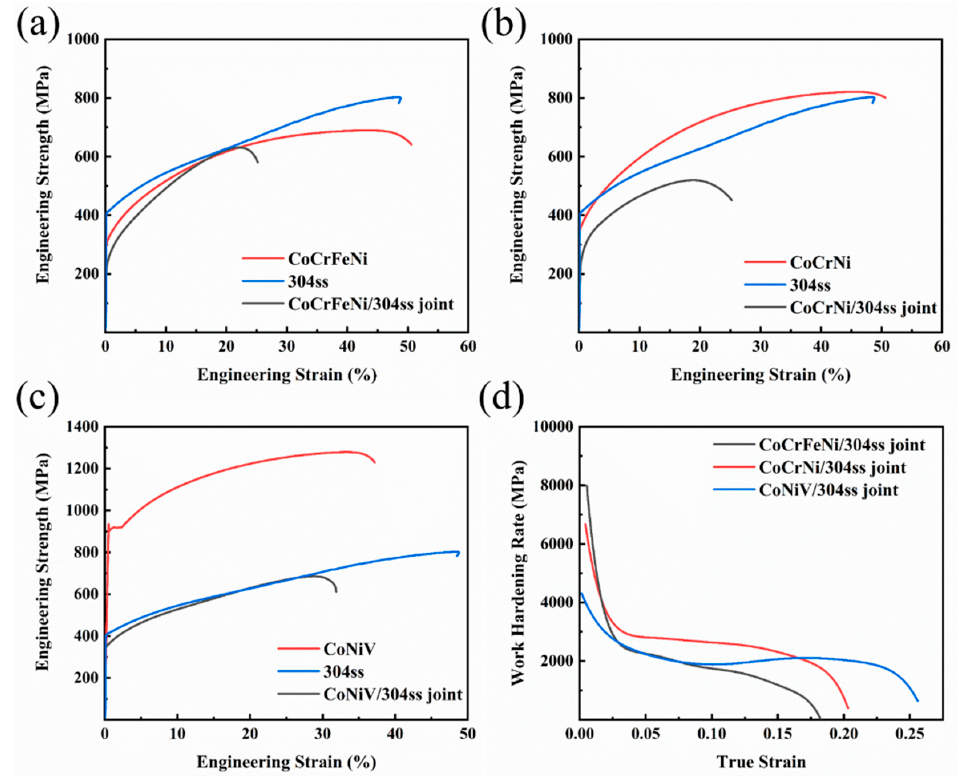
Figure 7. Mechanical behaviors of laser dissimilar welded joints. ( a – c ) Engineering stress–strain curves; ( d ) work hardening rate. curves; ( d ) work hardening rate. Table 3. Mechanical properties of base materials and as-welded samples. Table 3. Mechanical properties of base materials and as-welded